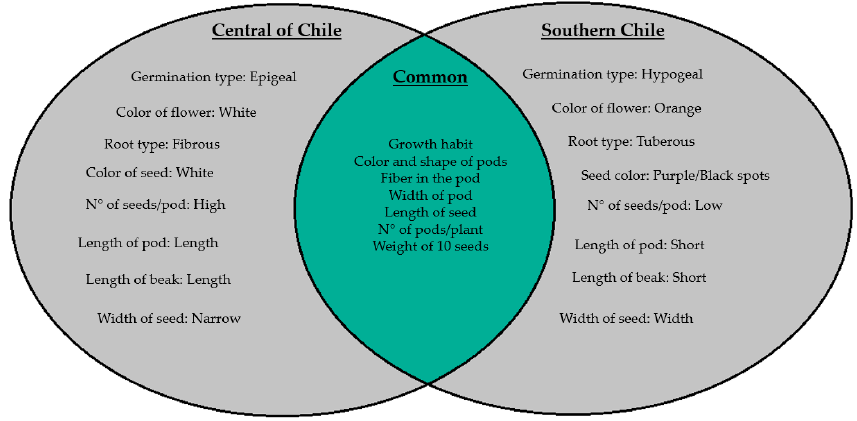
Figure 4. Summary of the similarities and differences between the P. coccineus lines evaluated for the most relevant morphological and agronomic traits. In the center are the similarities (common), while on the left and right the traits for the lines coming from the Center and South of Chile, respec- tively.